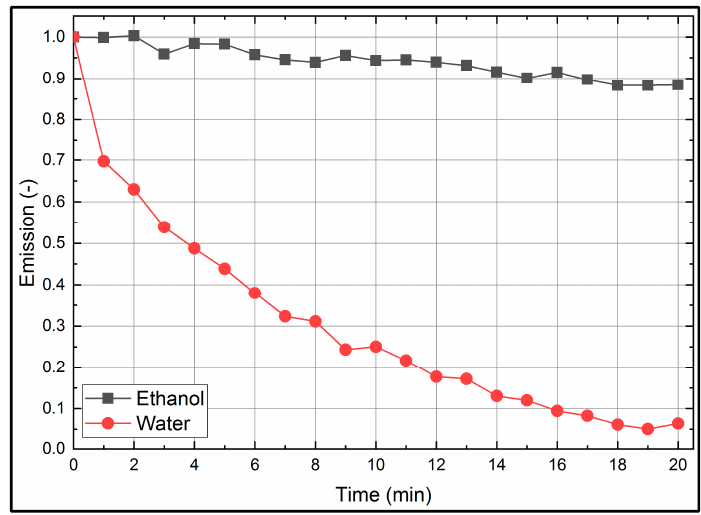
Figure 11. Photo-bleaching effect of Eosin-Y (15.86 mg/L) dissolved in ethanol and water at 293 K.